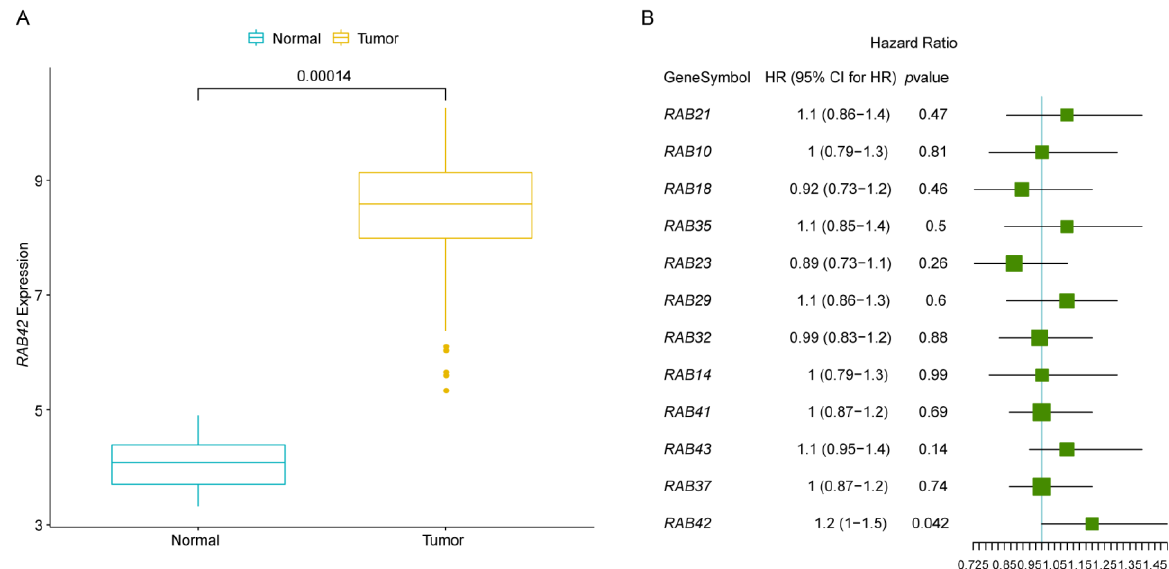
Figure 1. The RAB42 expression in glioblastoma (GBM) samples and normal samples. ( A ) The expression of RAB42 in GBM samples and corresponding normal samples based on the TCGA dataset, showed in a box plot. ( B ) Single-factor Cox analysis results of the RAB family genes based on the TCGA dataset displayed in a forest plot. HR: Hazard ratio; 95% CI: 95% confidence interval.